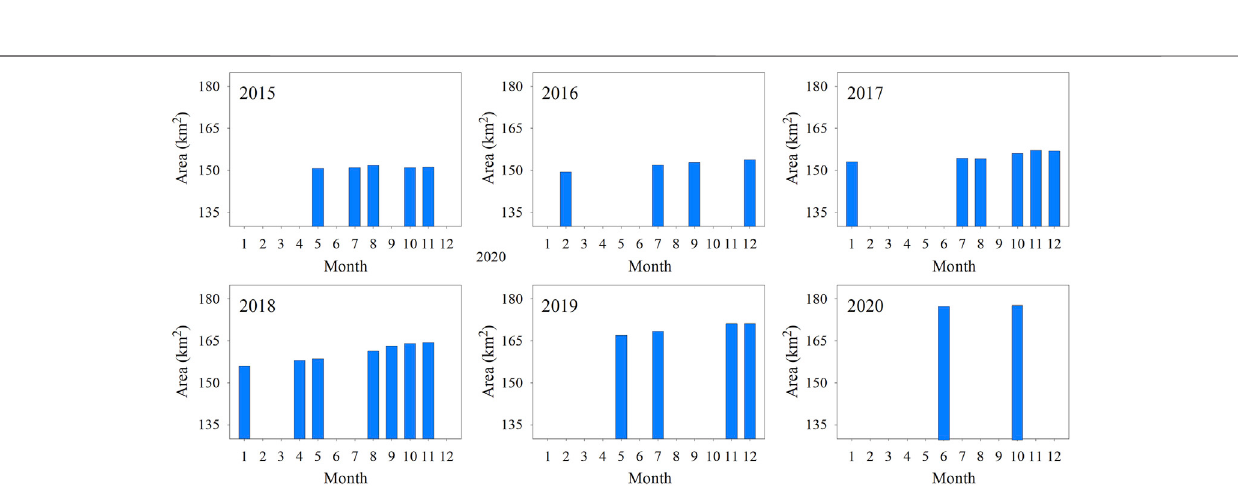
FIGURE 5 | Bar plots of monthly area variation of Tuosu Lake.